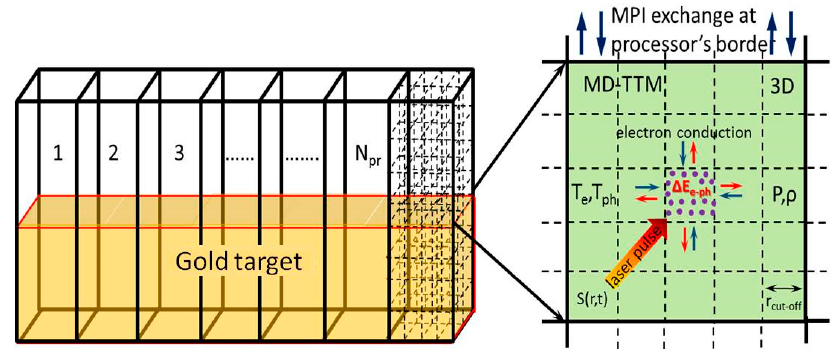
Figure 6. Computational box for simulations of laser-induced formation of Au NPs during the laser ablation process on the experimental scale [52]. The box is divided to the number of subcells N x and N y in X and Y directions correspondingly to be processed by N x *N y processor cores (left) in multiprocessing regime with the MPI library. Each core is divided to 3D mesh and shown in 2D view (right) with an illustration of the MD-TTM model scheme [51]. There we consider the effect of free carriers via the electron, T e , and phonon, T ph temperatures dynamics to describe the laser light absorption, S(r,t), the process of thermal energy exchange between electrons and phonons, Δ E e-ph , and fast electron heat conduction.